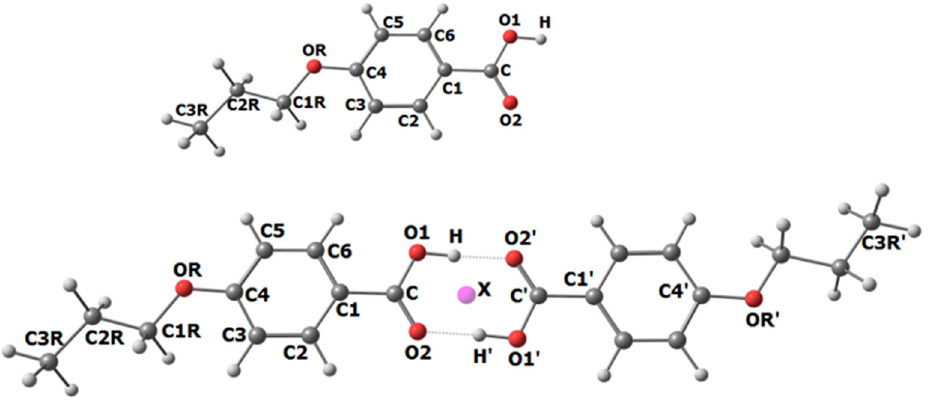
Figure 1. Geometric models of the POBA monomer and dimer with atomic numbering.